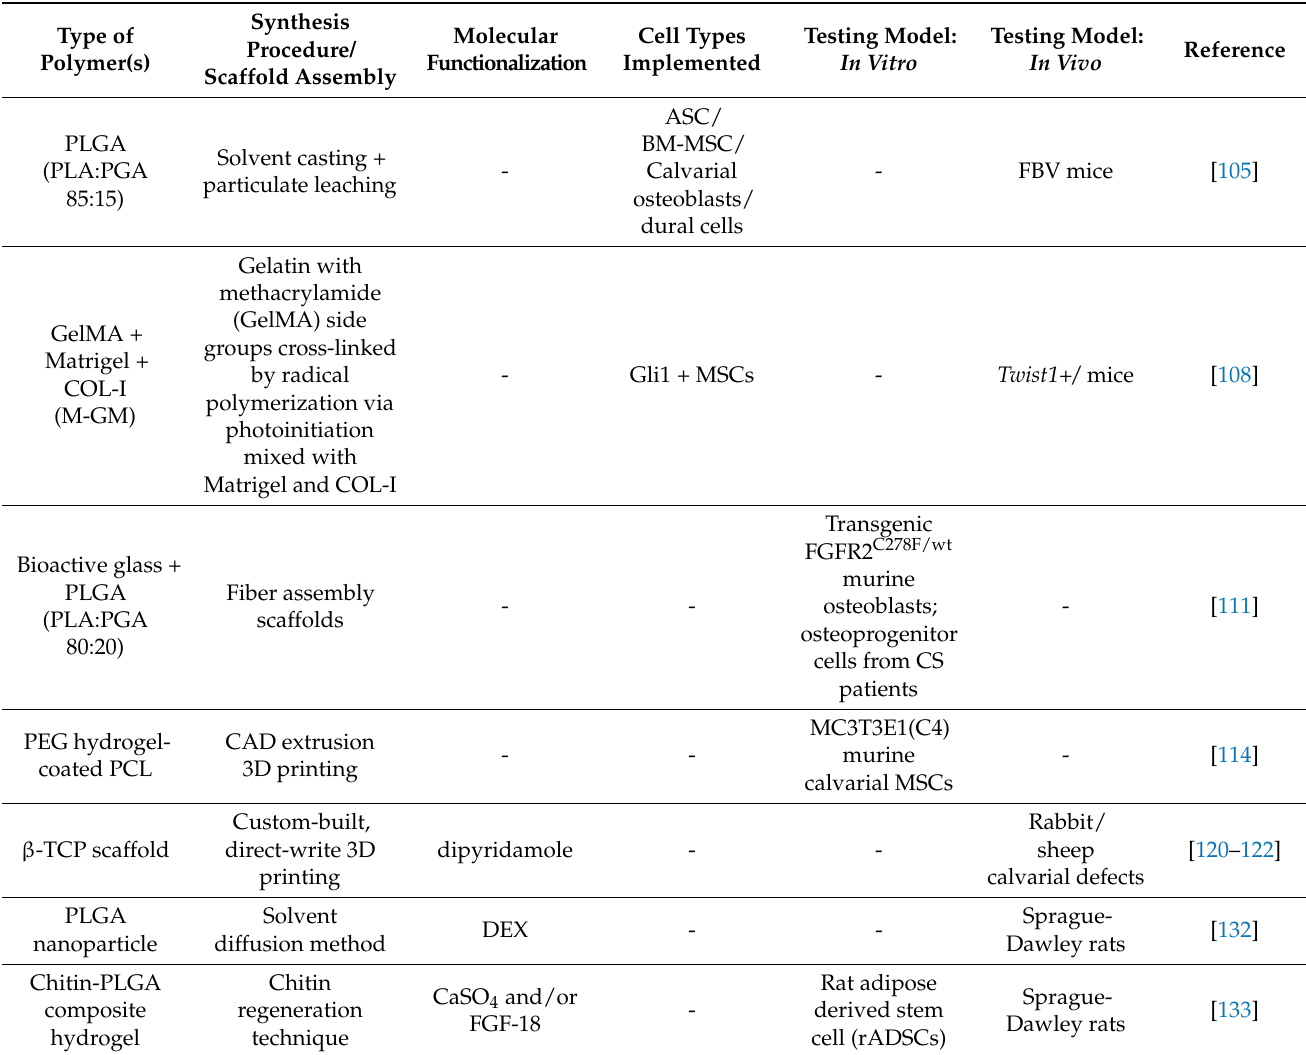
Table 4. Tissue engineering approaches for bone regeneration in calvarial